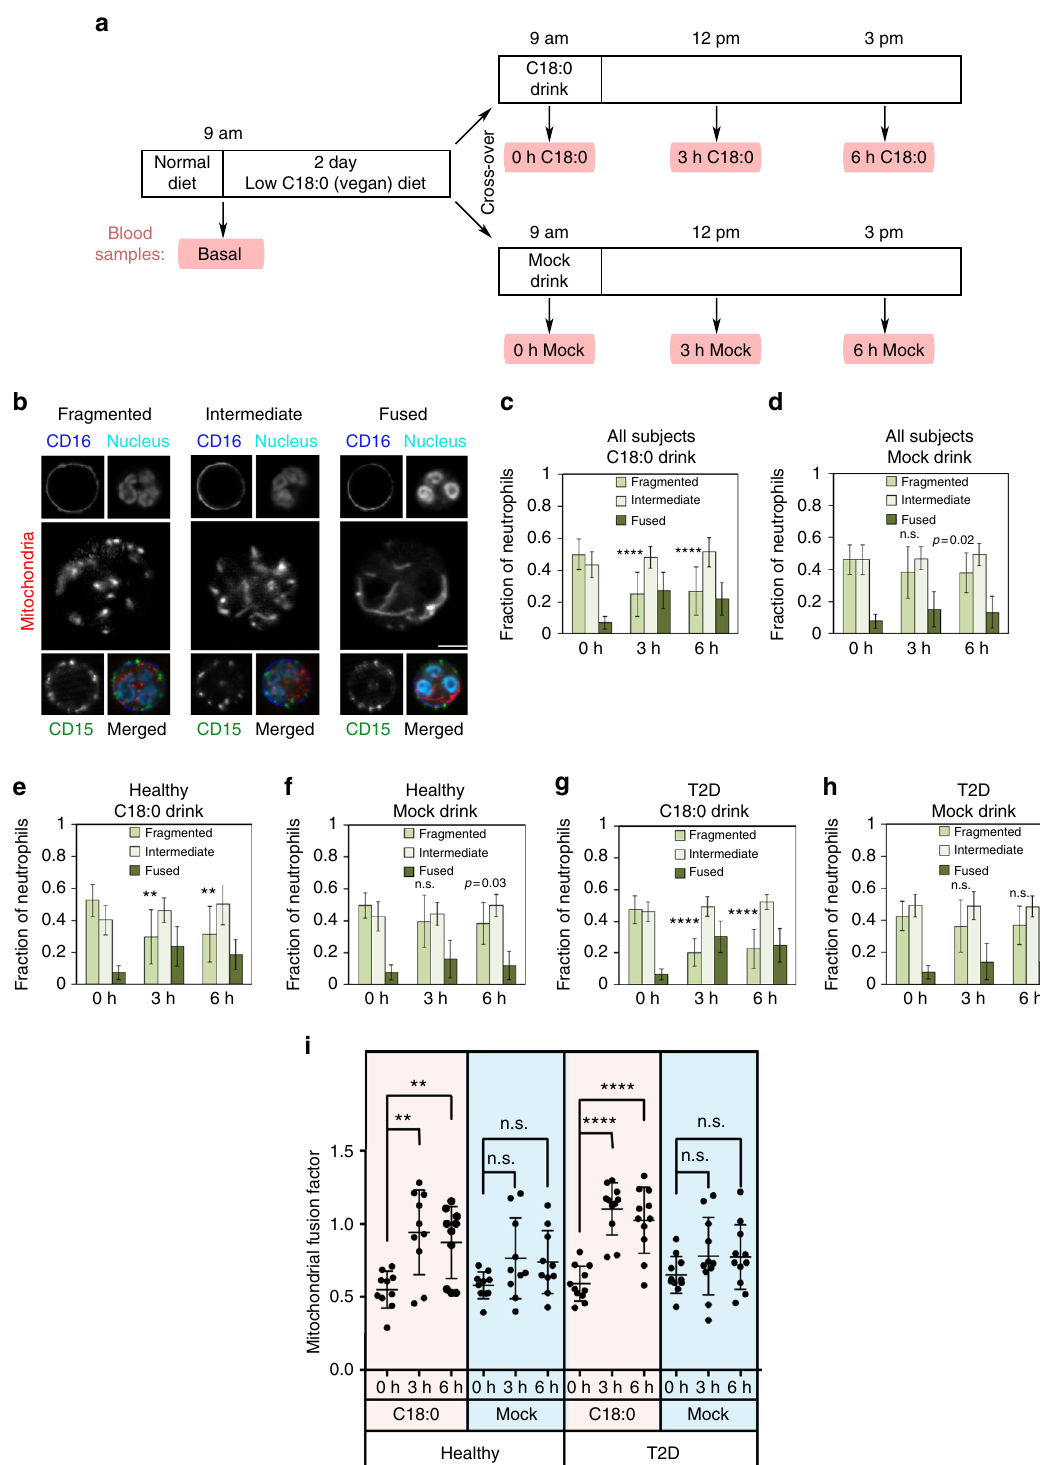
having more fused mitochondria after ingestion of C18:0. In contrast, the mock drink lacking C18:0 did not cause signi fi cant mitochondrial fusion in the very same people (Fig. 1d, f, h and Supplementary Fig. 2 for a statistical analysis comparing C18:0 to mock, using simplex plots on the entire distribution). Although not signi fi cant, the mock drink did cause a small but consistent increase in mitochondrial fusion (Fig. 1d), perhaps because the